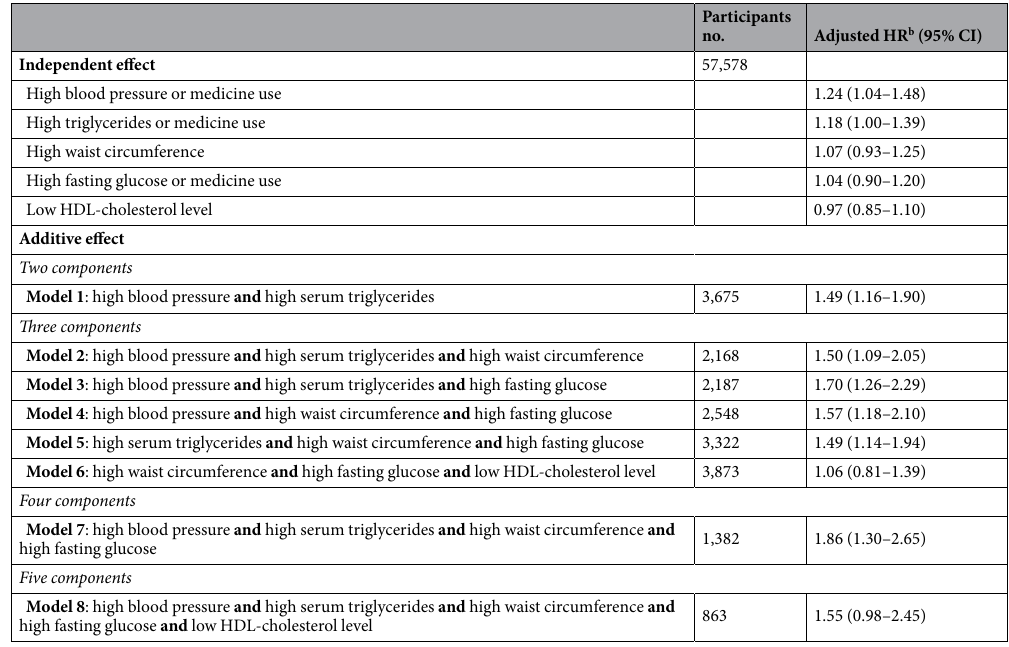
Table 4. Hazard ratios of subclinical hypothyroidism comparing participants with different combinations of metabolic syndrome components (N = 66,822 a ). a Excluding participants with prevalent hypothyroidism at the baseline (N = 1,151), and those with missing information or measurement error of thyroid function test (N = 631), and those who had ever received undetermined thyroid medicine during the follow-up period (N = 139). b Multivariable Cox proportional hazards analyses were adjusted for sex, age group, low educational level, physical inactivity, cigarette smoking, and alcohol consumption. Reference group: normal value for all 5